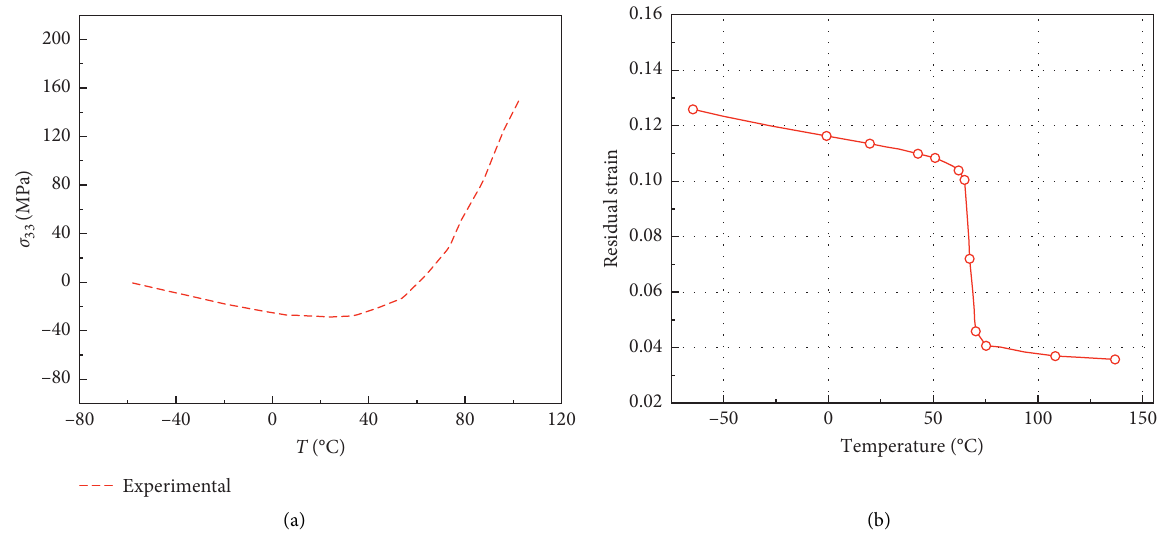
Figure 4: Experimental temperature recovery characteristic of (a) constraint heating and (b) stress-free heating.